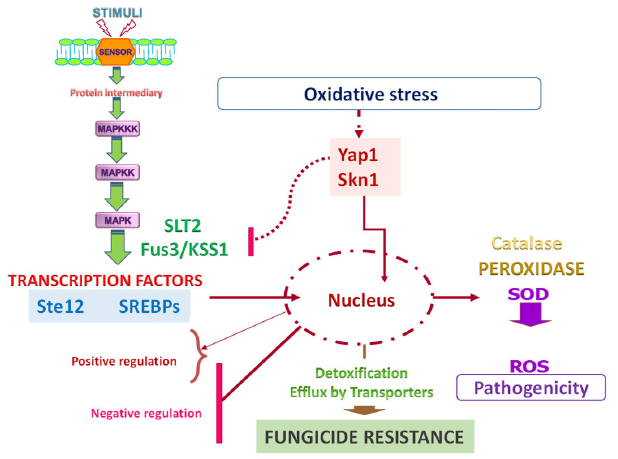
Figure 5. Schematic of regulatory mechanisms involved in fungal resistance that are also related to fungicide virulence and oxidative stress. fungicide virulence and oxidative